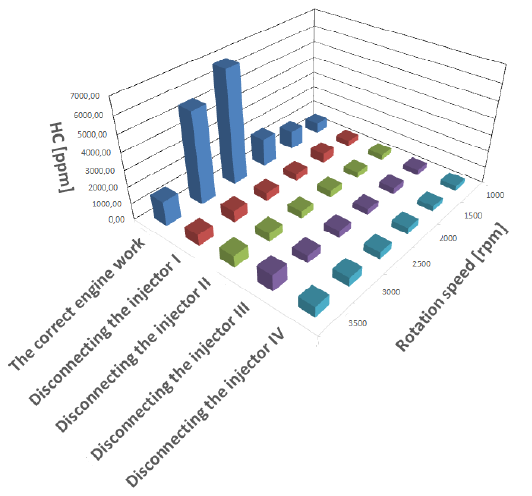
Fig. 9. The hydrocarbon content in the exhaust gas of a BMW engine Fig. 12. The content of nitrogen oxides in the exhaust gas of a BMW fueled with petrol working efficiently and in the without ignition in indi- engine fueled with petrol working efficiently and in the without ignition in vidual cylinders individual